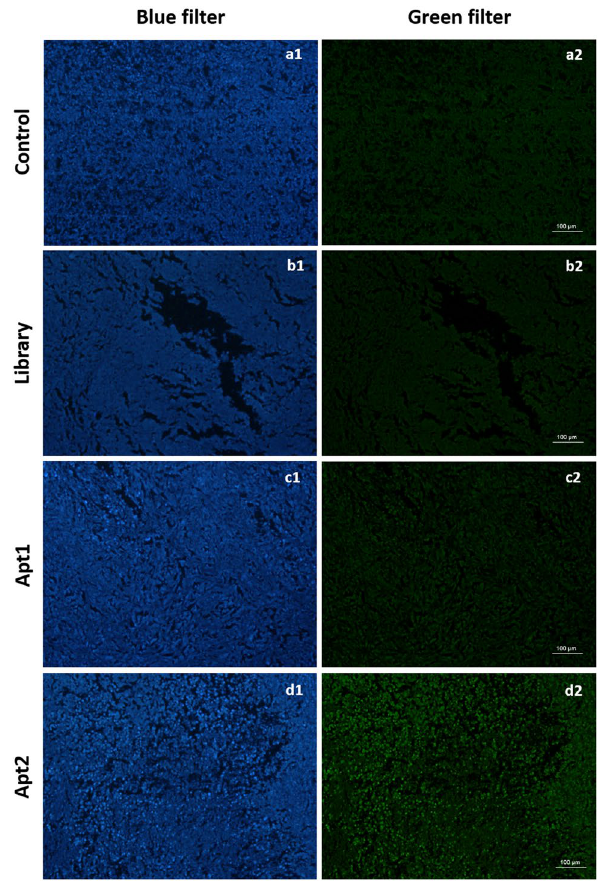
Figure 8. In vitro binding ability of Apt1 and Apt2 to human breast cancer tissue section detected through immunofluorescence staining. Control stands for experiments performed without FAM-labelled aptamer ( a ); with FAM-labelled ssDNA library ( b ) and with FAM-labelled Apt1 ( c ) and Apt2 ( d ), respectively. (1) blue filter, nuclei stained with DAPI and (2) green filter, FAM-labelled library, Apt1, or